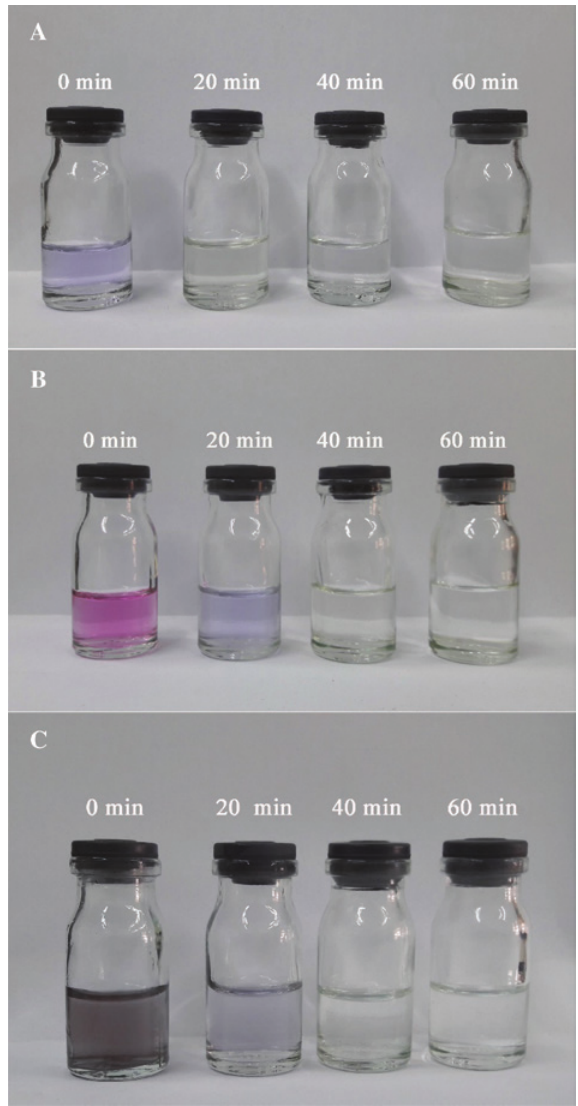
Figure 19: The UV-Vis absorption of the dyes in the presence of photocatalysts (A) acid blue 29, (B) acid violet 7 and (C) acid black 1. Figure 20: The photodegradation by the PbFe 12 O 19 / around 16 emu/g and coercivity of about 0.4 Oe have been achieved. Figure 17 shows the magnetization curve of the PbFe O -TiO nanocomposite calcined at 800 ° C. The 12 19 2 results indicate that the sample exhibits ferromagnetic behaviour with coercivity of about 981 Oe and saturation magnetization of around 14 emu/g.